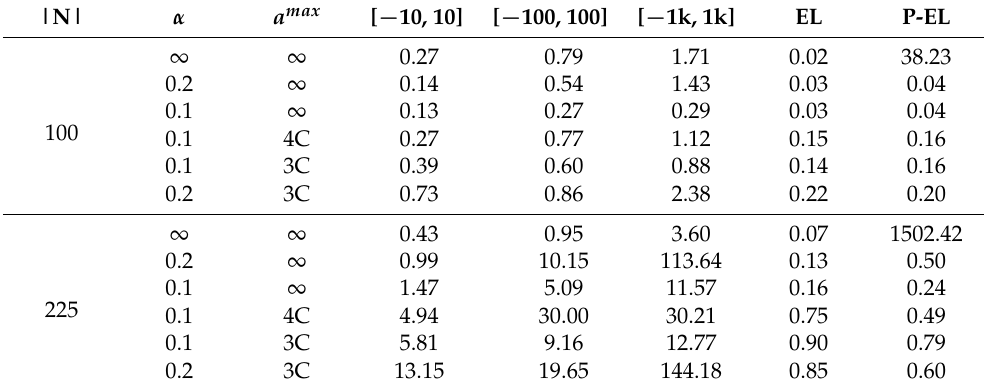
Table 7. Running times in seconds.